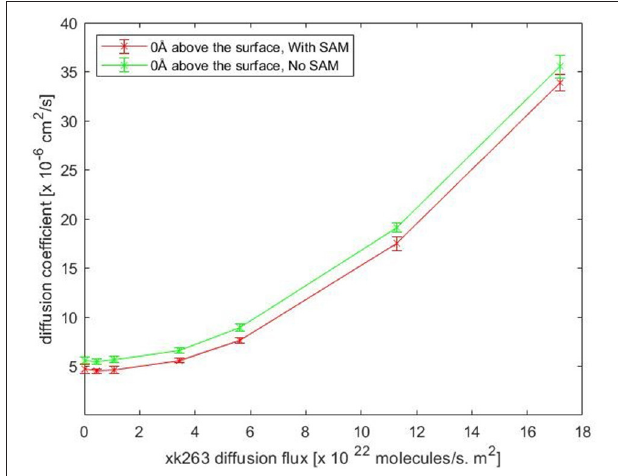
FIGURE 5 | Plot of translational diffusion coefficient of xk263. Diffusion coefficient increases with xk263 diffusion flux. (see Supplementary Table 1 for numerical data).